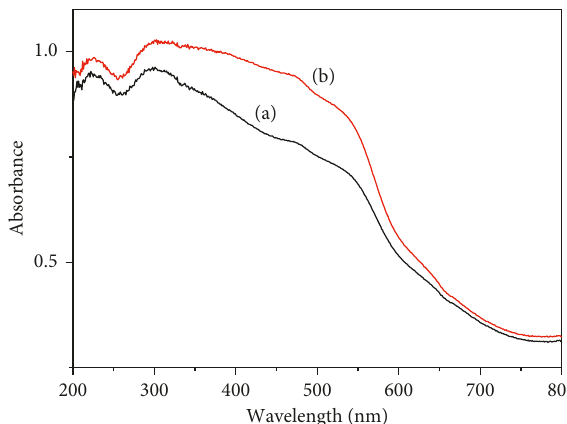
Figure 5: The UV-Vis diffuse reflectance spectra of MgFe